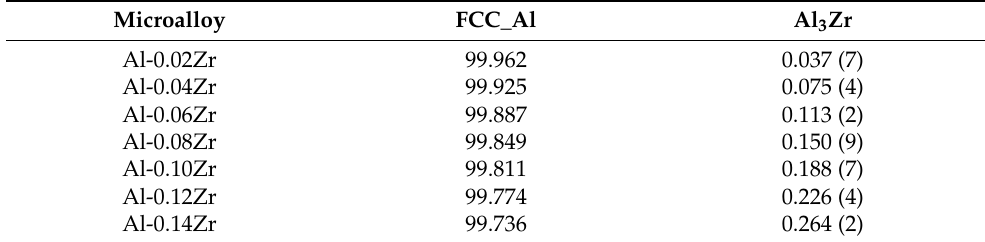
Table 2. Relative amounts of the solid phases in the studied alloys at room temperature (wt.%). Microalloy